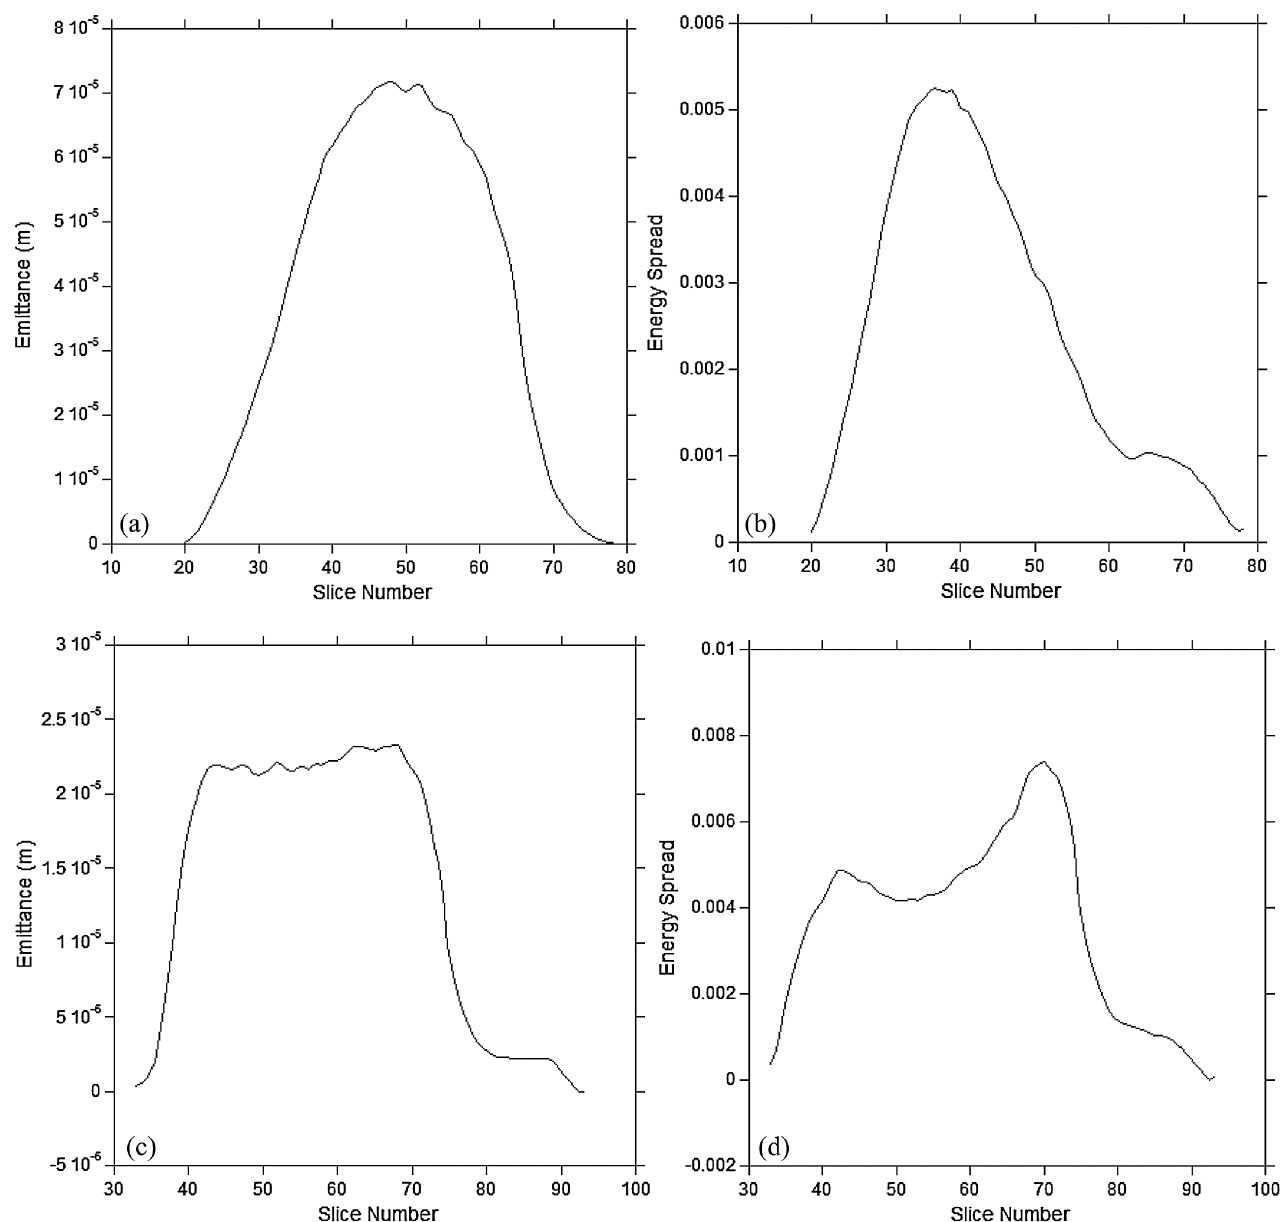
FIG. 10. (a) Slice emittance and (b) slice energy spread for the EEX for a 1 nC bunch charge, (c) slice emittance, and (d) slice energy spread for the chicane with a 1 nC bunch